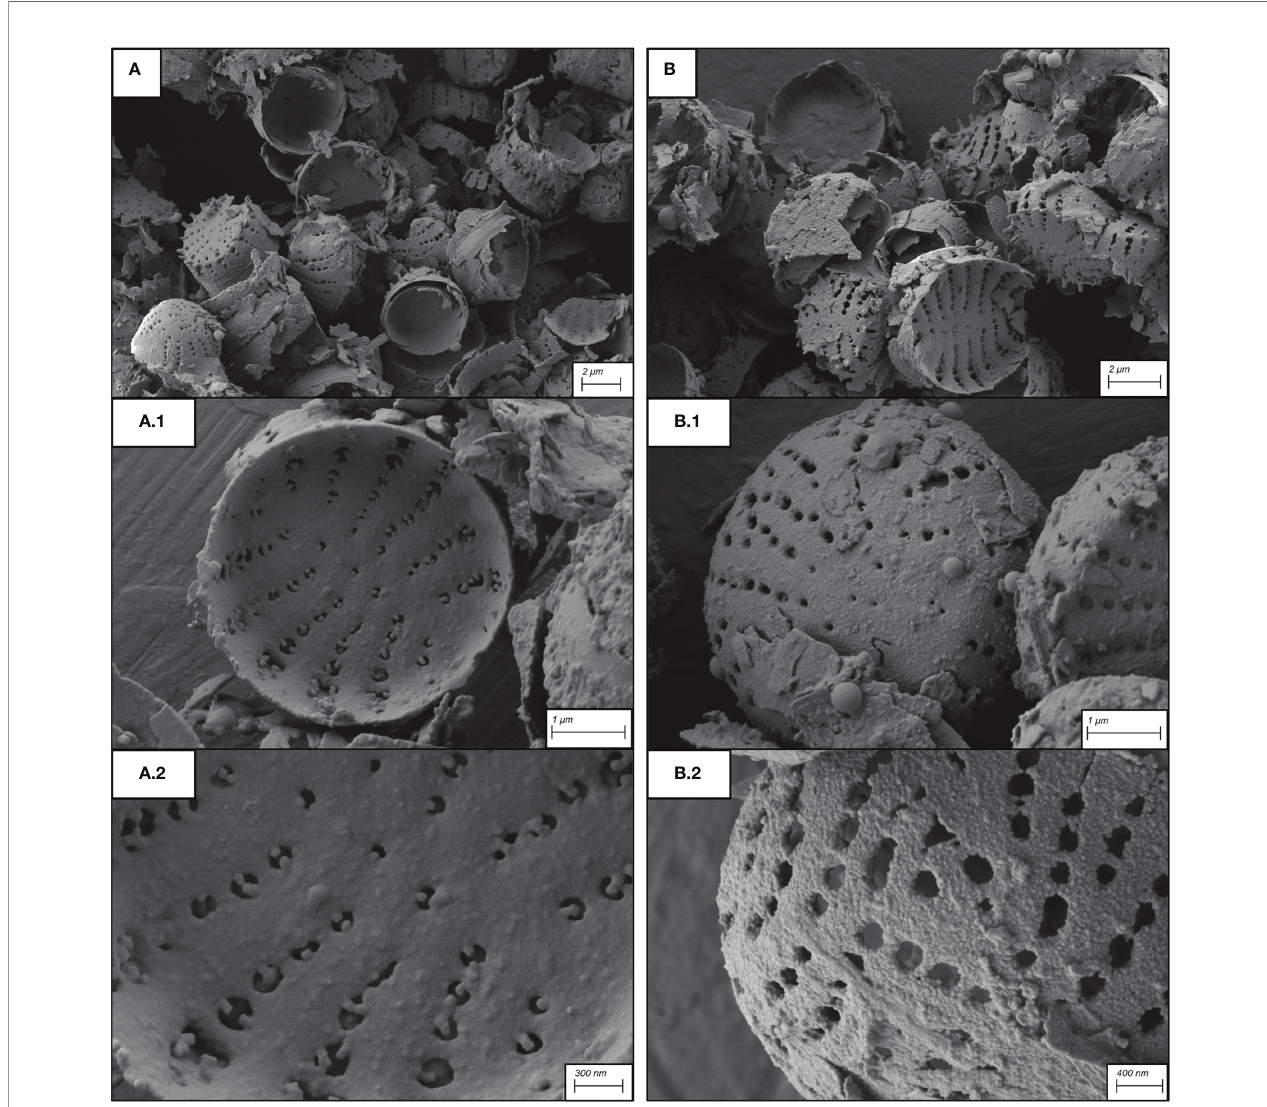
FIGURE 4 | SEM micrographs of frustules after application of the two protocols. (A) : Protocol 1 ; (B) : Protocol 2. (A1, A2, B1, B2) represent high magni fi cation of A and B